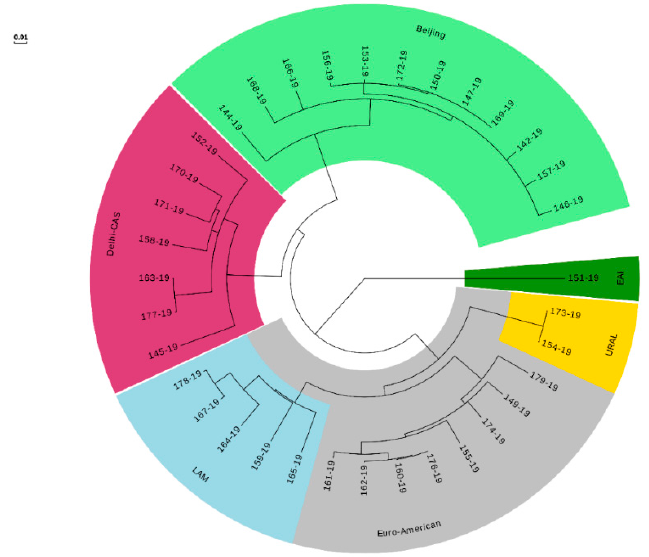
Figure 2. Maximum likelihood tree built from 544 single nucleotide polymorphism (SNP) positions of the 35 rifampicin-resistant Mycobacterium tuberculosis isolates mapped to the genome of H37Rv (NC_000962.3) shown as a circular phylogram.